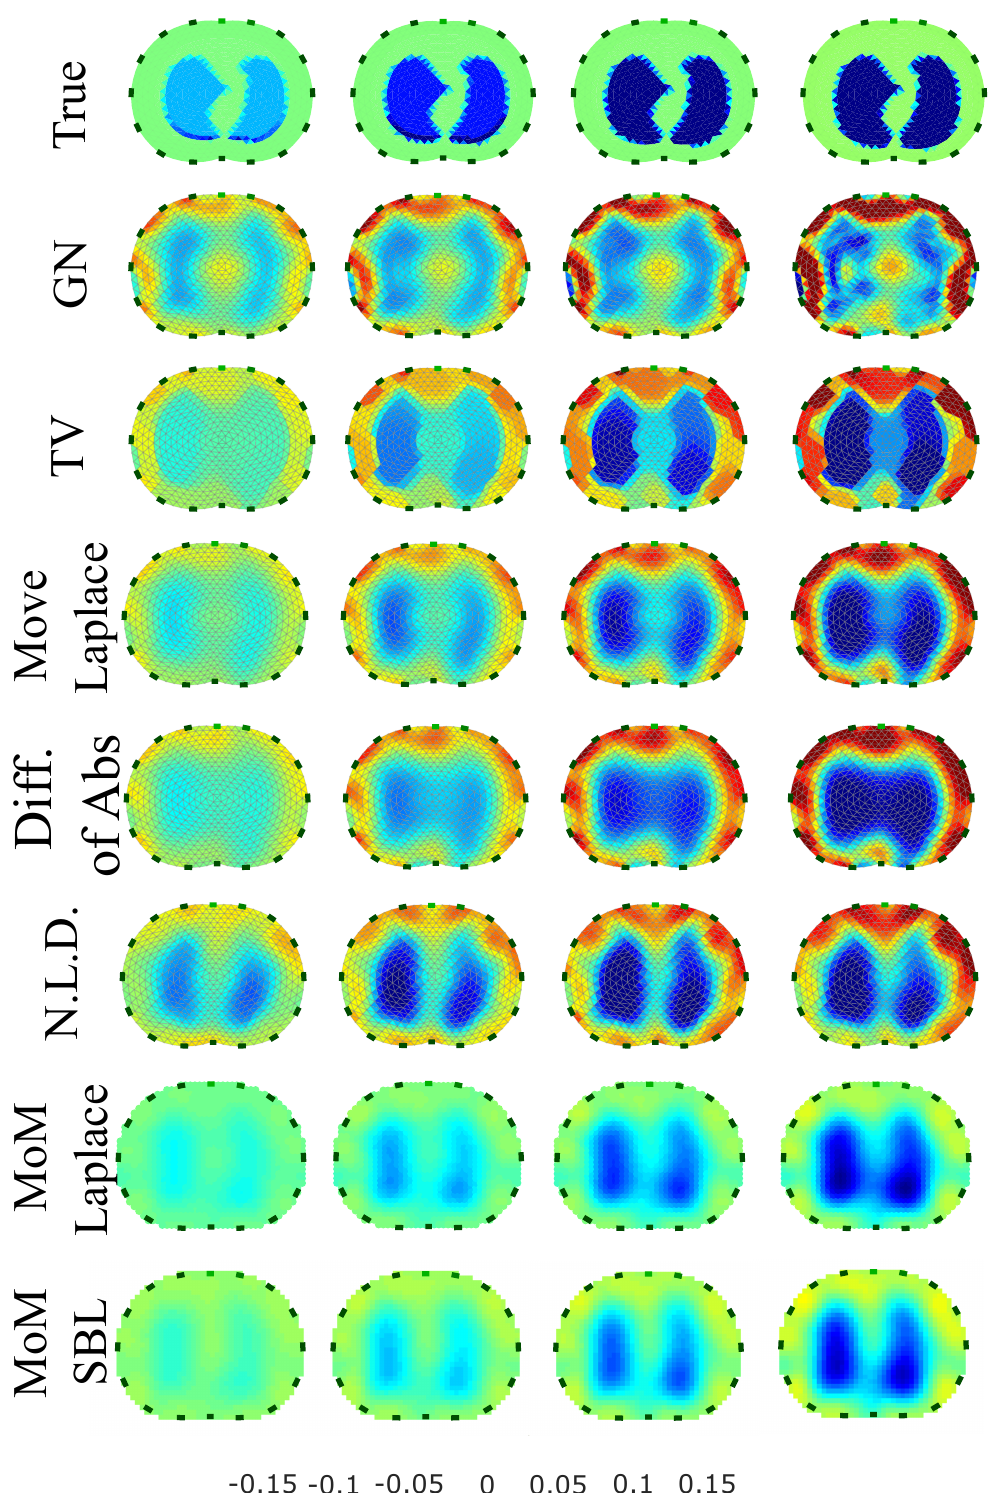
Figure 11. Reconstructed EIT images (conductivity differences) for the second